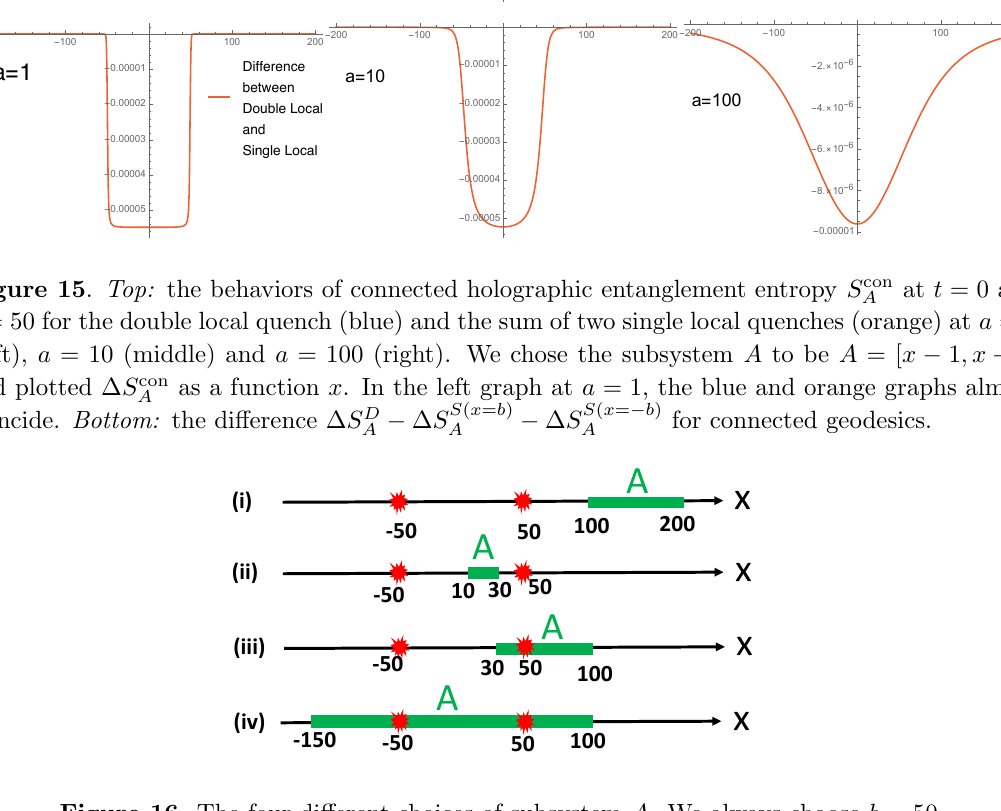
Figure 16 . The four di(cid:11)erent choices of subsystem A . We always choose b =